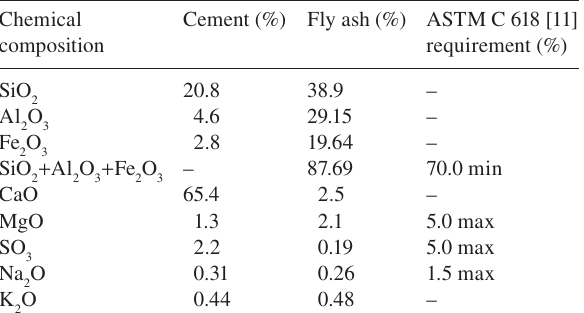
Table 3 Chemical composition of Portland cement and Class F fl y ash.